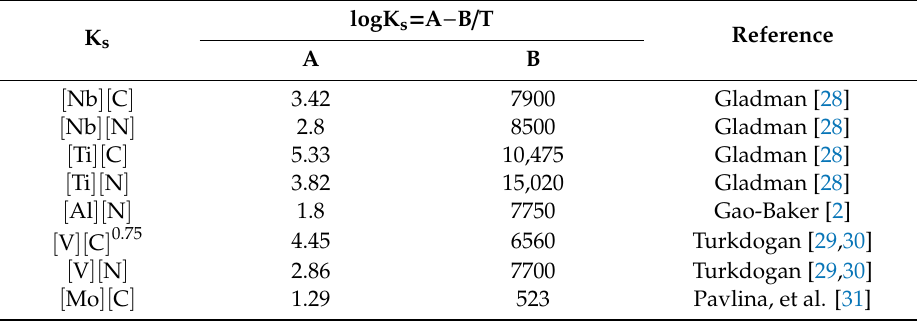
Table A1. Solubility products of precipitates of interest in